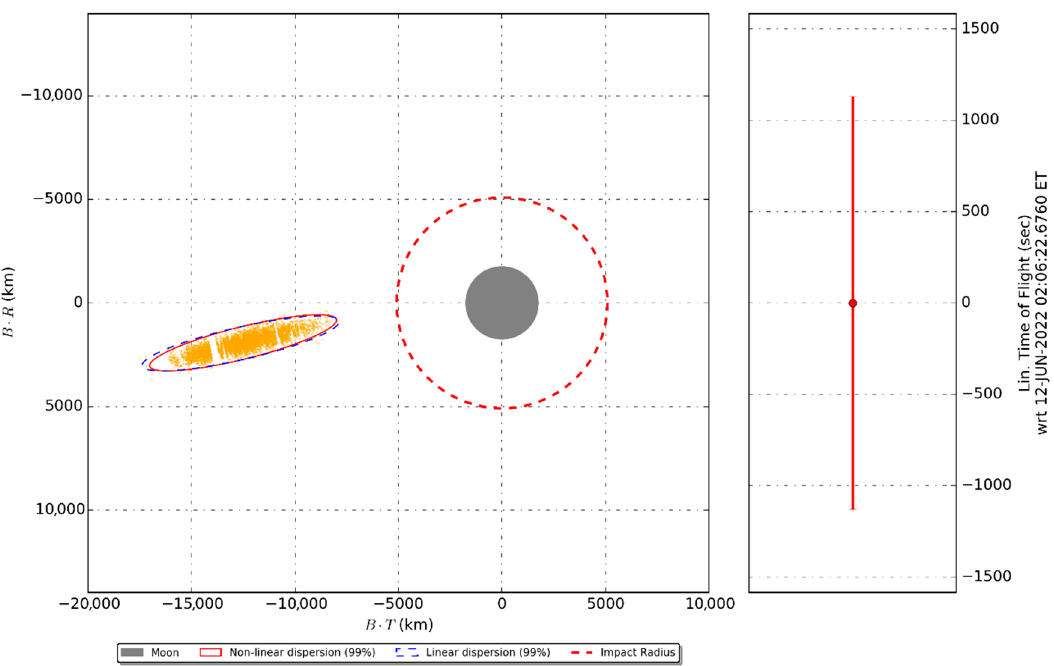
Figure 4. Statistics of the uncontrolled trajectory error with respect to the nominal trajectory from the deployment up to the first apogee A1.